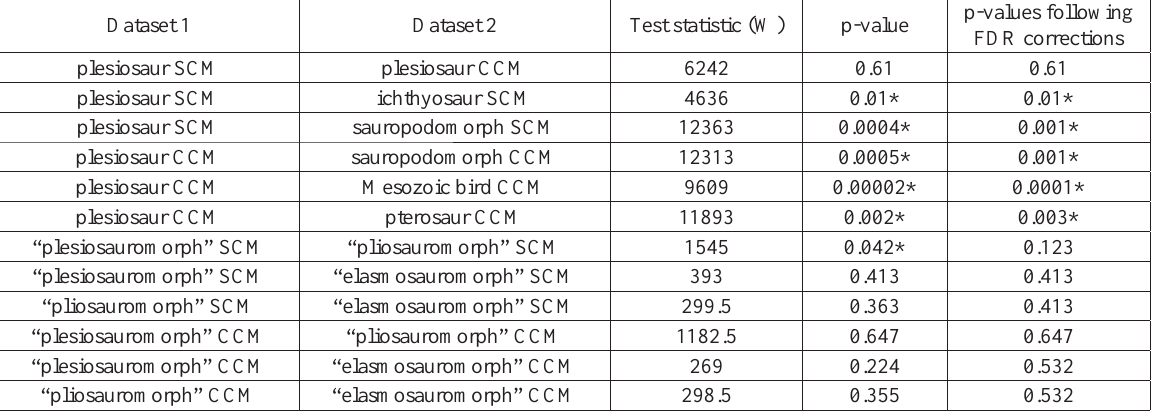
Table 3. Results of comparisons of the population median and distribution of completeness values for different Mesozoic vertebrate clades and plesiosaur morphotypes using Mann-Whitney-Wilcoxon tests. Asterisks indicate statistically significant results. See Fig. 5 for boxplot compari- sons of clade comparisons. Abbreviations: CCM, character completeness metric; FDR, false discovery rate; SCM, skeletal completeness metric.